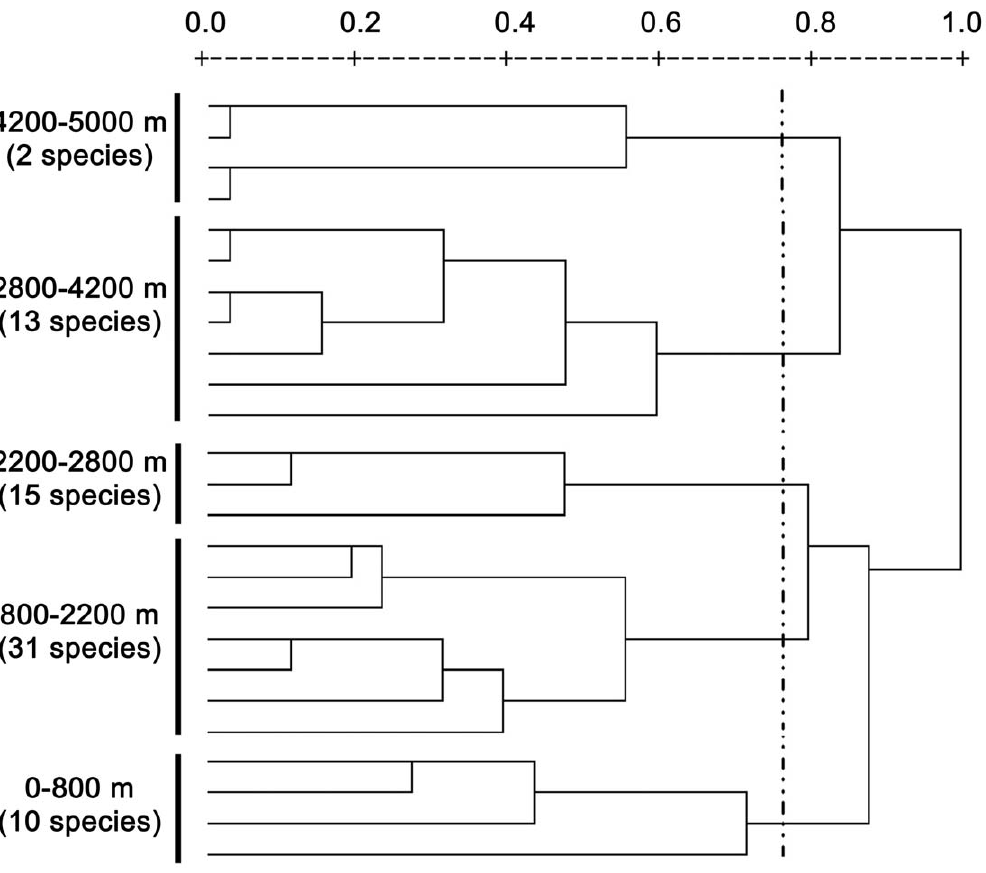
Figure 5. The classification of 200-m altitudinal intervals between 0 and 5000 m for spiny frogs. The Jaccard (1901) similarity measure is used. The between-groups method is used for the cluster analysis based on the similarity coefficient matrix.